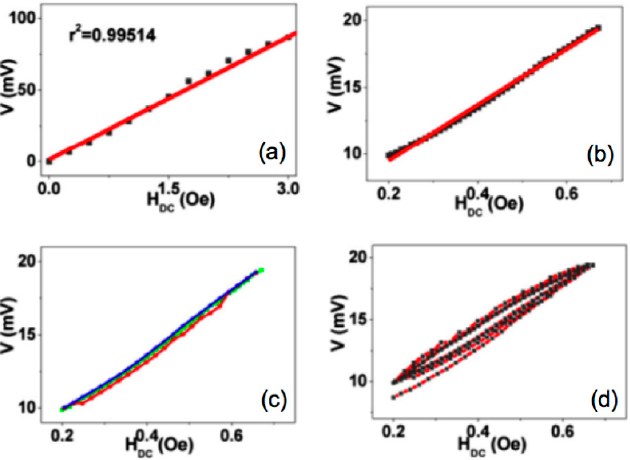
Figure 4. DC magnetic field sensor characterization: ( a ) linearity, ( b ) resolution and sensitivity ( c ) accuracy and ( d ) hysteresis. Figure taken with permission from [21].